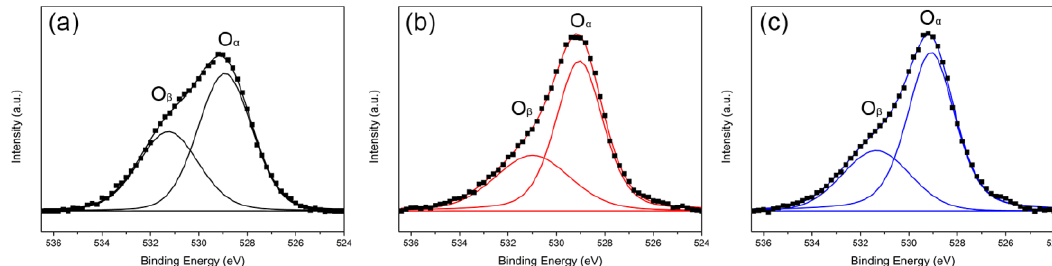
Figure 7. O 1s XPS spectra of ( a ) Ru/CeO 2 -NRs, ( b ) Ru/CeO 2 -NCs, and ( c ) Ru/CeO 2 -NPs. Table 3. XPS data of Ru/CeO 2 -NR, Ru/CeO 2 -NC, and Ru/CeO 2 -NP samples. Samples Ru 4+ (%)